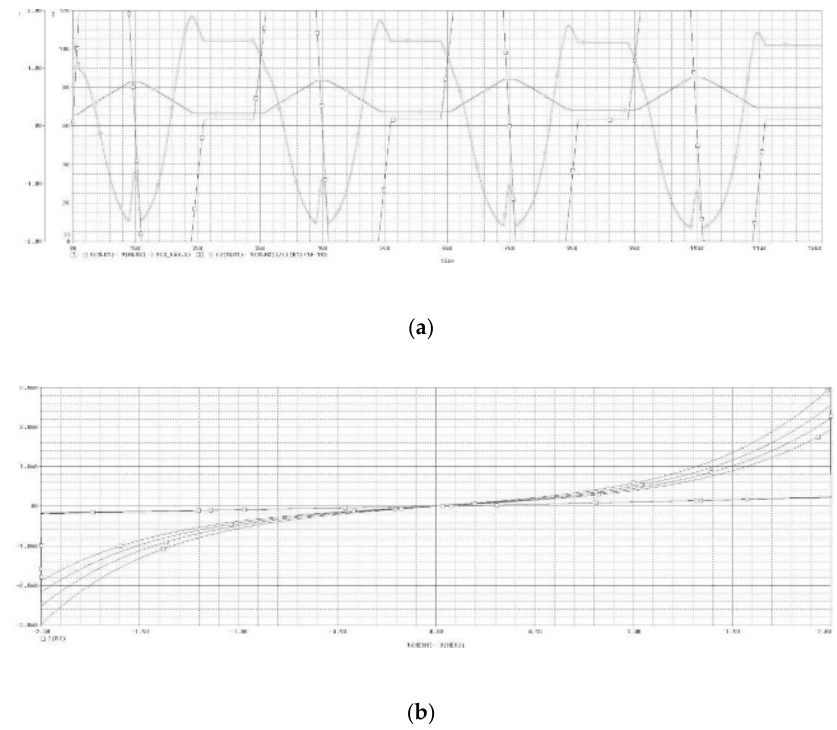
Figure 8. ( a ) Time diagrams of the memristor voltage, state variable, and memristance, according to the memristor model with a modified Biolek window function; ( b ) current-voltage relationship of memristors for the passive matrix during the processes of writing and reading information. Table 2. Parameters and characteristics of a single memristor memory element, 1T1R and 10T25R.